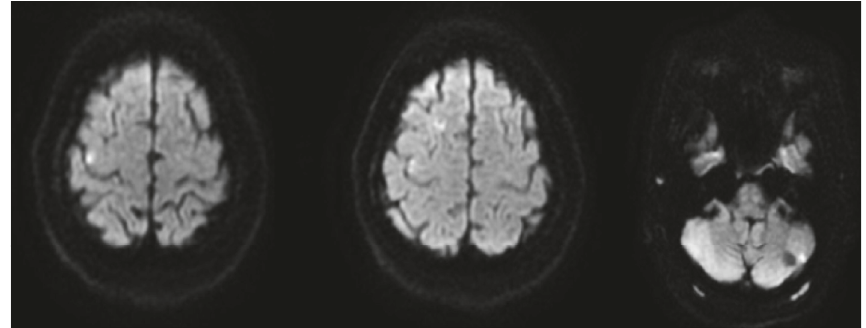
Figure 1: MRI of the brain without contrast showing small foci of diffusion restriction involving the right frontal lobe and left cerebellar hemisphere consistent with areas of acute infarctions. Abbreviation. MRI: magnetic resonance imaging.